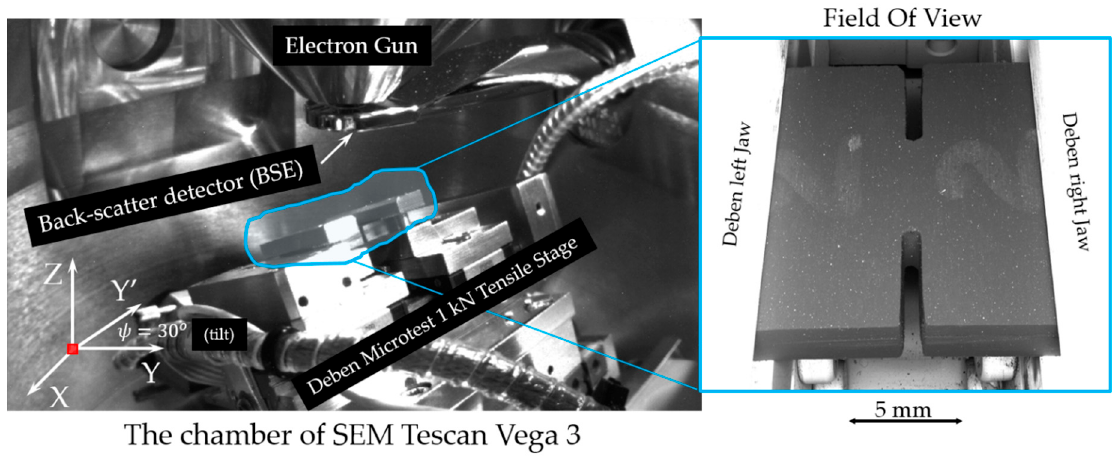
Figure 11. The view of the experimental setup—the chamber of the SEM Tescan Vega 3.